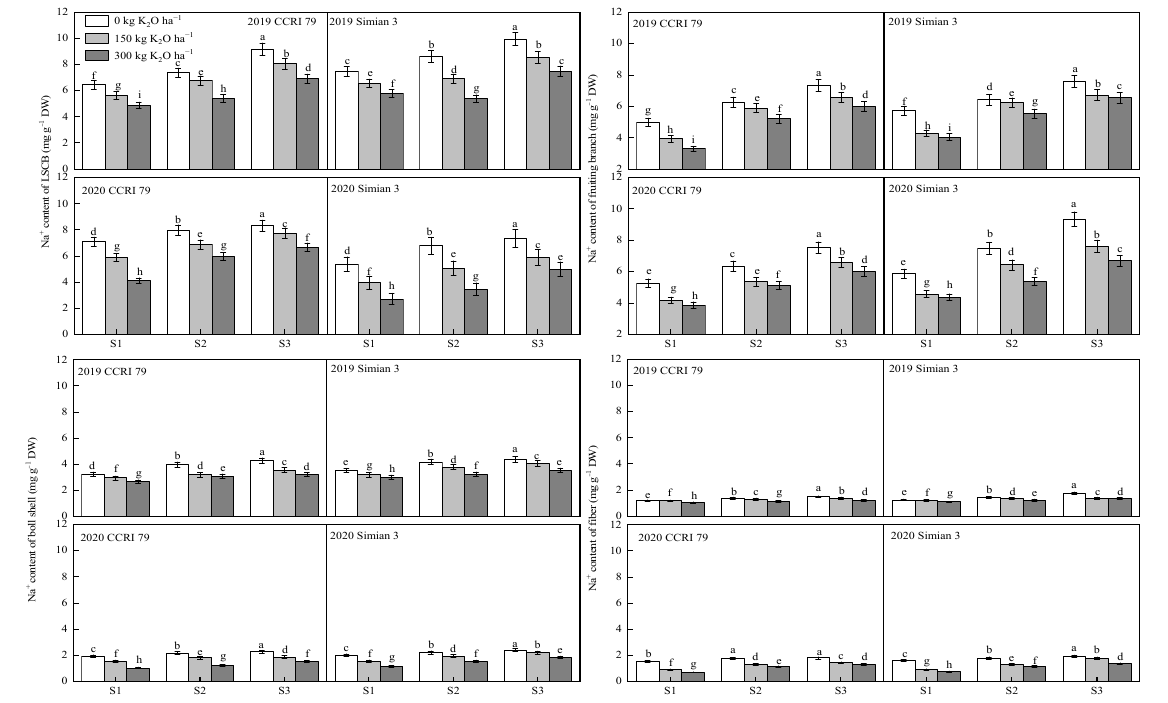
Figure 3. Effect of K application on the content of Na + in the boll − leaf system at 15 DPA under salt stress. S1, low salinity; S2, moderate salinity; S3, high salinity. Different letters denote significant differences between the mean values( p < 0.05). 3.4. Effect of K Application on the K + /Na + Ratio in the Boll–Leaf System under Salt Stress At 15 DPA, the K + /Na + ratio in the LSCB, fruiting branch, boll shell, and fiber of the boll–leaf system declined continuously with increasing salt stress (Figure 4). The effect of K300 was greater than that of K150. The ratio of K + /Na + in the cotton fibers was higher than that in other organs. CCRI 79 had a greater K + /Na + ratio than Simian 3.